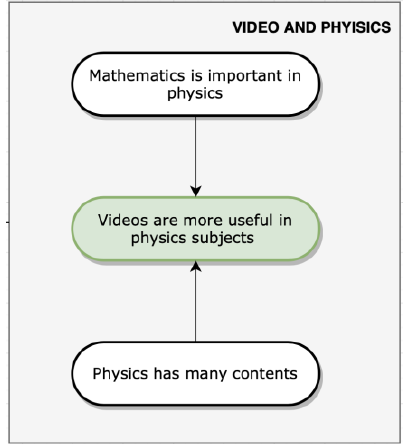
Figure 9. Enlargement of the box “ video versus text. ” .